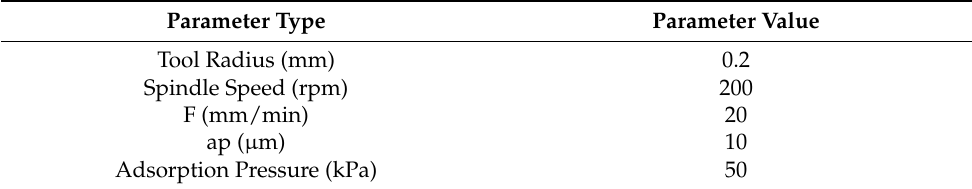
Table 2. The processing related